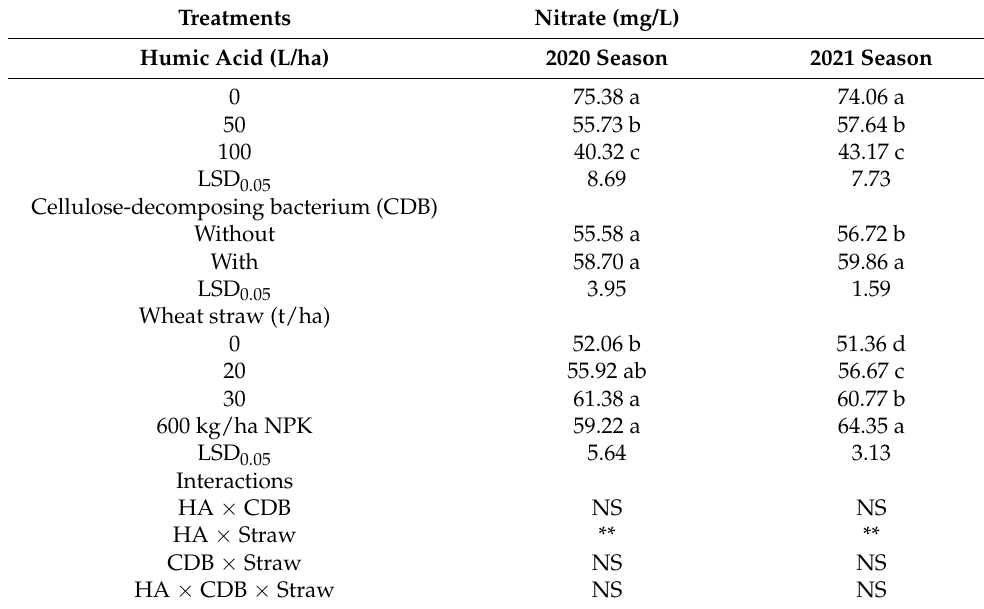
Table 3. Effects of humic acid, cellulose-decomposing bacterium and wheat straw levels on squash nitrate accumulation during 2020 and 2021 planting